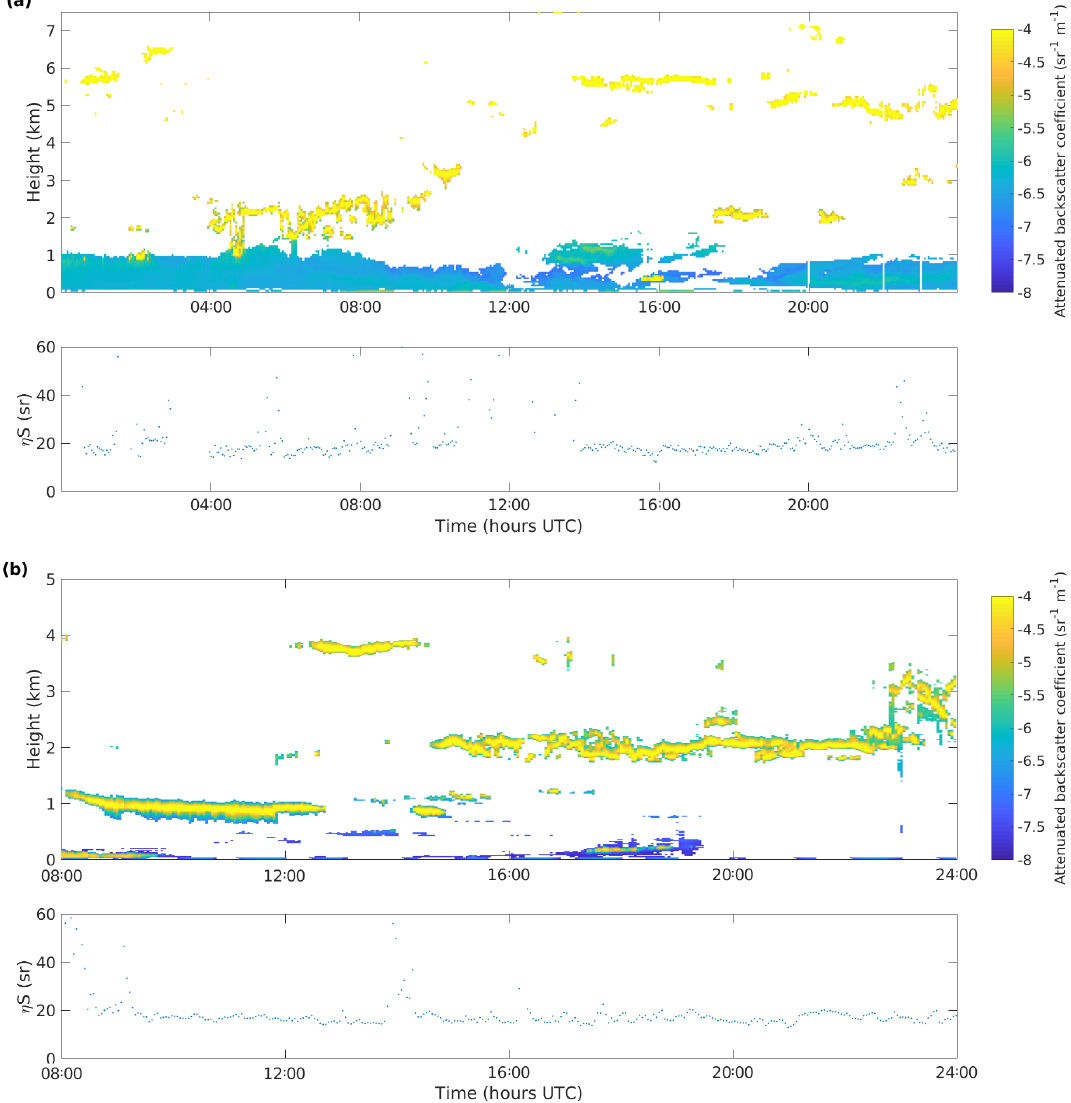
Figure 8. Doppler lidar attenuated backscatter coefficient and apparent lidar ratio, ηS , from (a) Darwin on 8 May 2012 and (b) NSA on 20 August